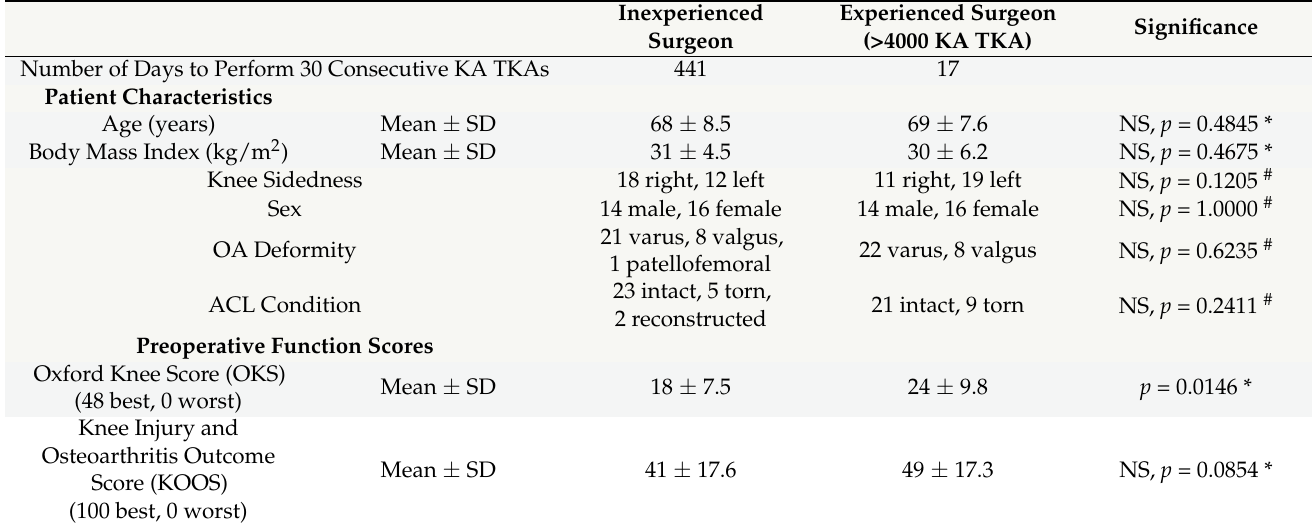
Table 1. Shows pre-operative characteristics, knee conditions, and function scores for the 30 patients treated by inexperienced and experienced surgeons and significant